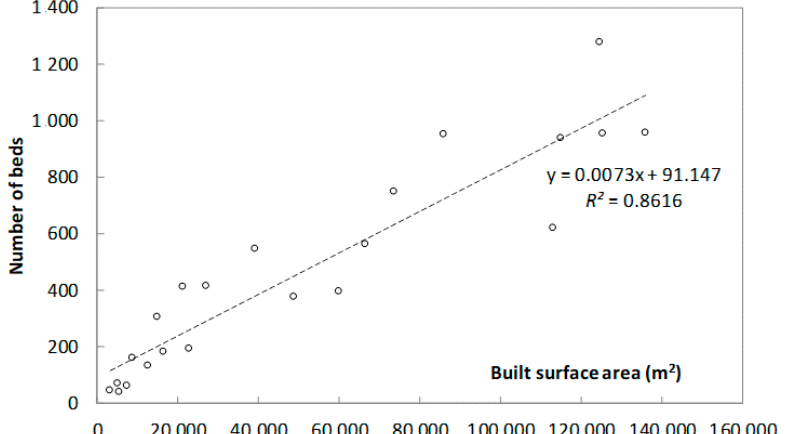
Figure 1. The relation between number of beds and built surface area for the hospitals under